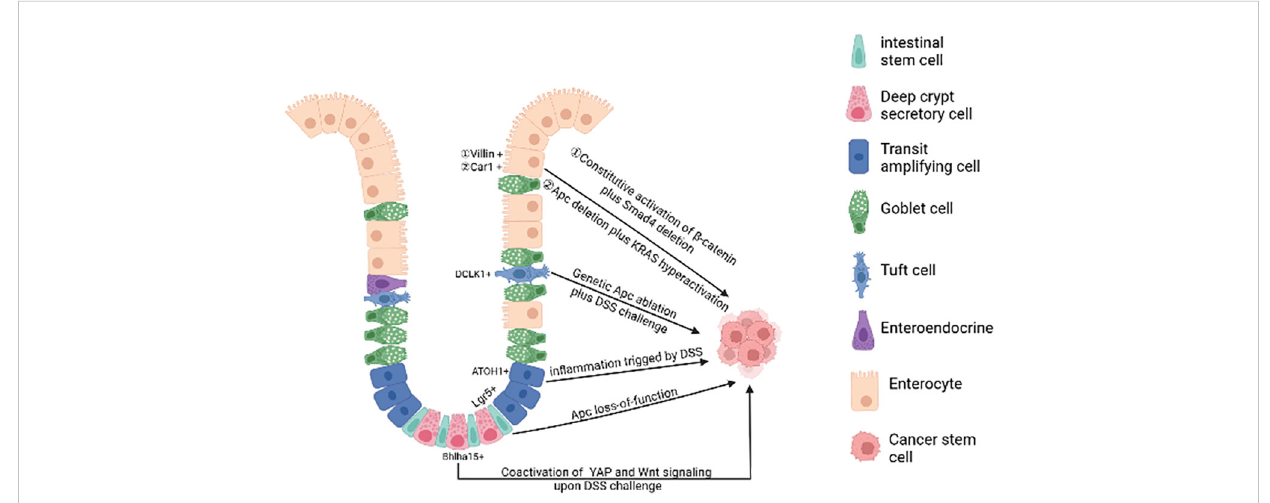
FIGURE 1 The cell of origin of colorectal cancer. A single gene mutation of the Wnt signaling pathway(such as Apc deletion) in intestinal stem cells prompts them to transform into cancer stem cells. Bhlha 15 + and ATOH1 + precursor cells can also transform malignantly upon DSS challenge, initiating bottom-up tumorigenesis. Apc mutation plus dysregulation of multiple signaling pathways (such as NF k B, SMAD, YAP) or under long-lasting in fl ammatory milieu may induce dedifferentiation of terminally differentiated cells (enterocytes and tuft cells), initiating top-down tumorigenesis. (Created in